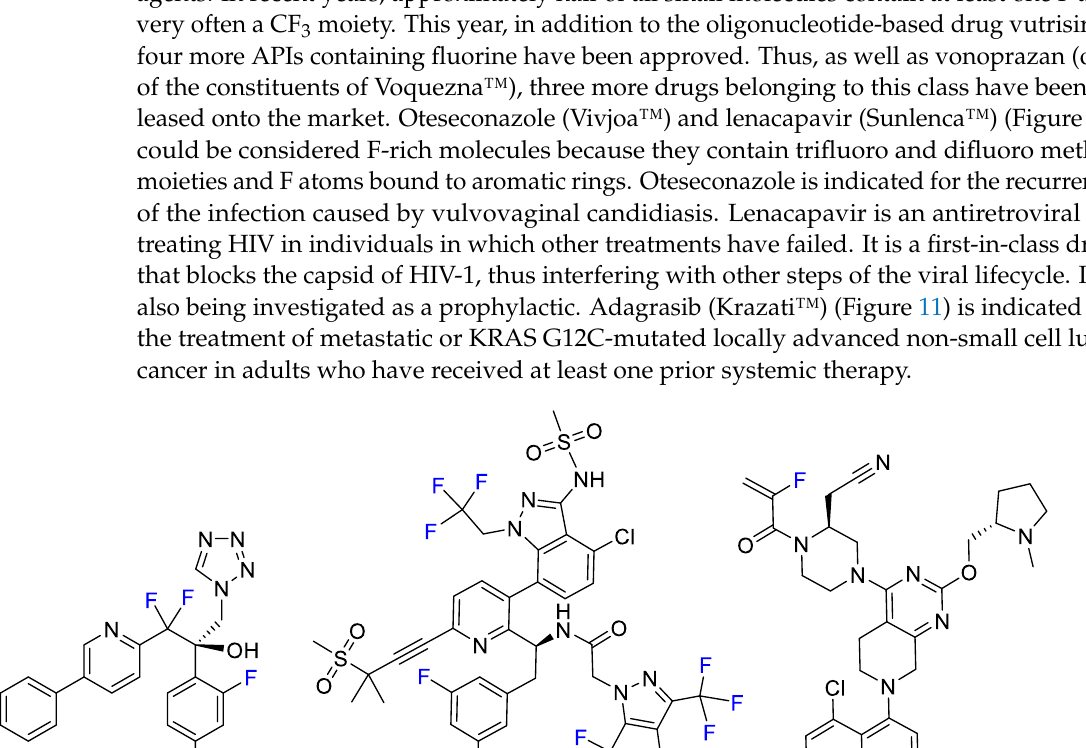
Figure 10. Structures of ganaxolone and tapinarof, both drugs inspired by natural products.